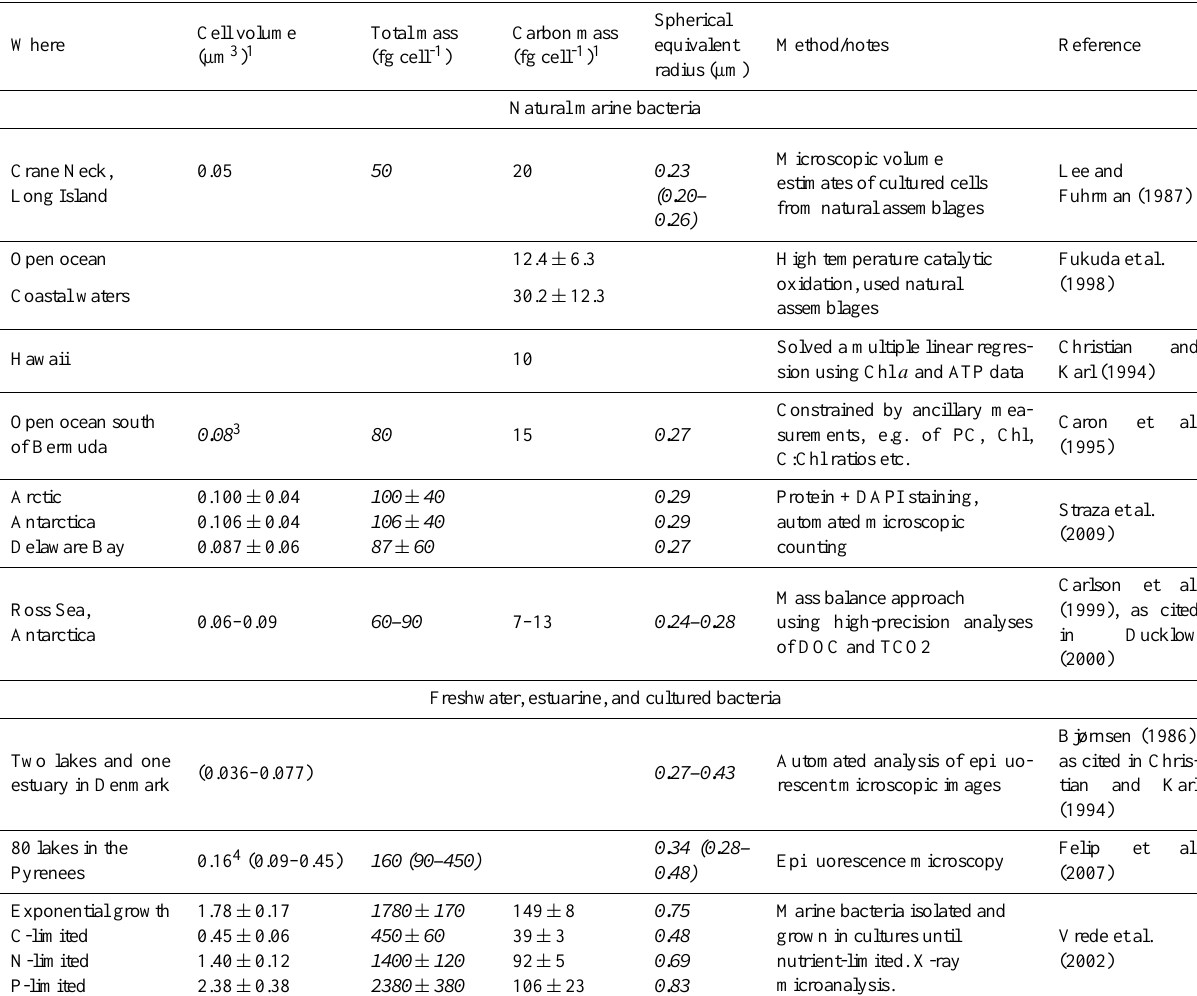
Table 2. Size of bacterial cells from natural marine populations, and other aquatic bacteria samples. Unless otherwise stated, values are reported as mean ± standard deviation and/or as range. Published values are printed in upright font; values derived from the published values are printed in